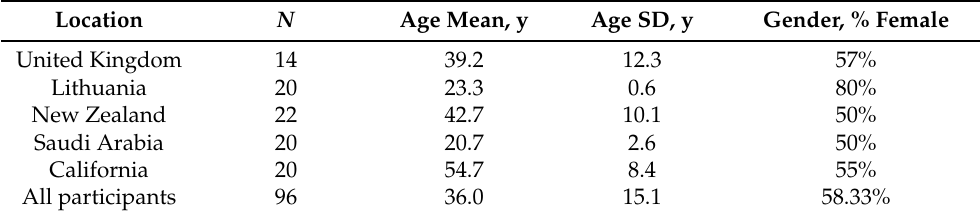
Table 1. The age and gender breakdown for all participants by country. Note that columns 2–5 display the number of participants, mean and standard deviation of their age (in years) as well as the percentage of female participants,